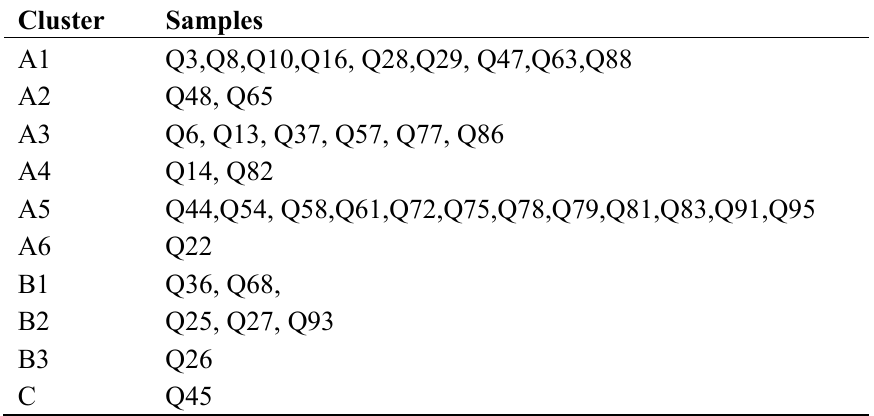
Table 4. Samples contained in each of the clusters of the dendrogram shown in Figure